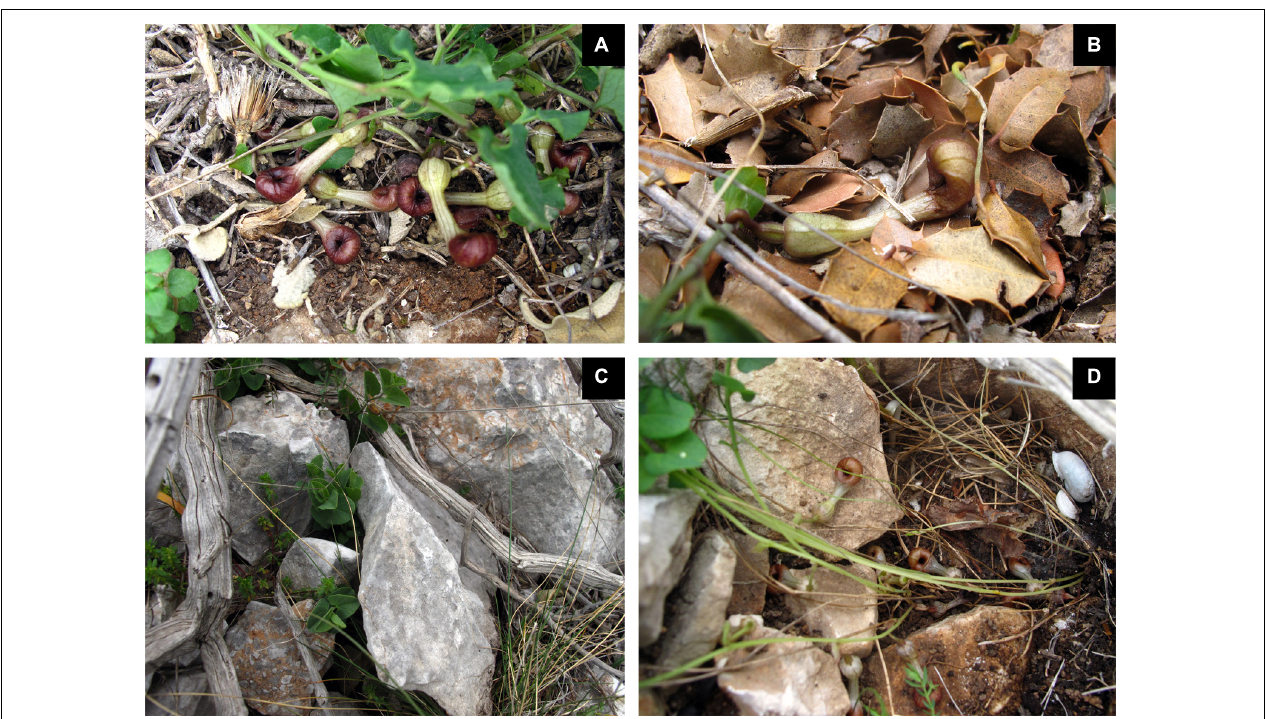
FIGURE 1 | Aristolochia microstoma and its flowers in their natural habitat in Greece (Athens, Mt. Egaleo): The small flowers (length = 2 cm to 3 cm) are presented on ground-level, either well hidden in the leaf litter (A,B) , or between rocks (C) , where they are not visible from above ( D ; rock removed to see the